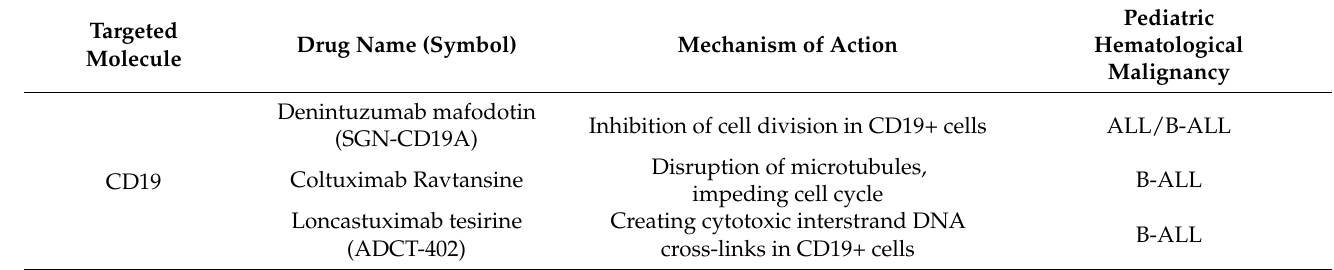
Table 3. Antibody–drug conjugates and monoclonal antibodies used in the treatment of pediatric cases of acute lymphoblastic leukemia and acute myeloid